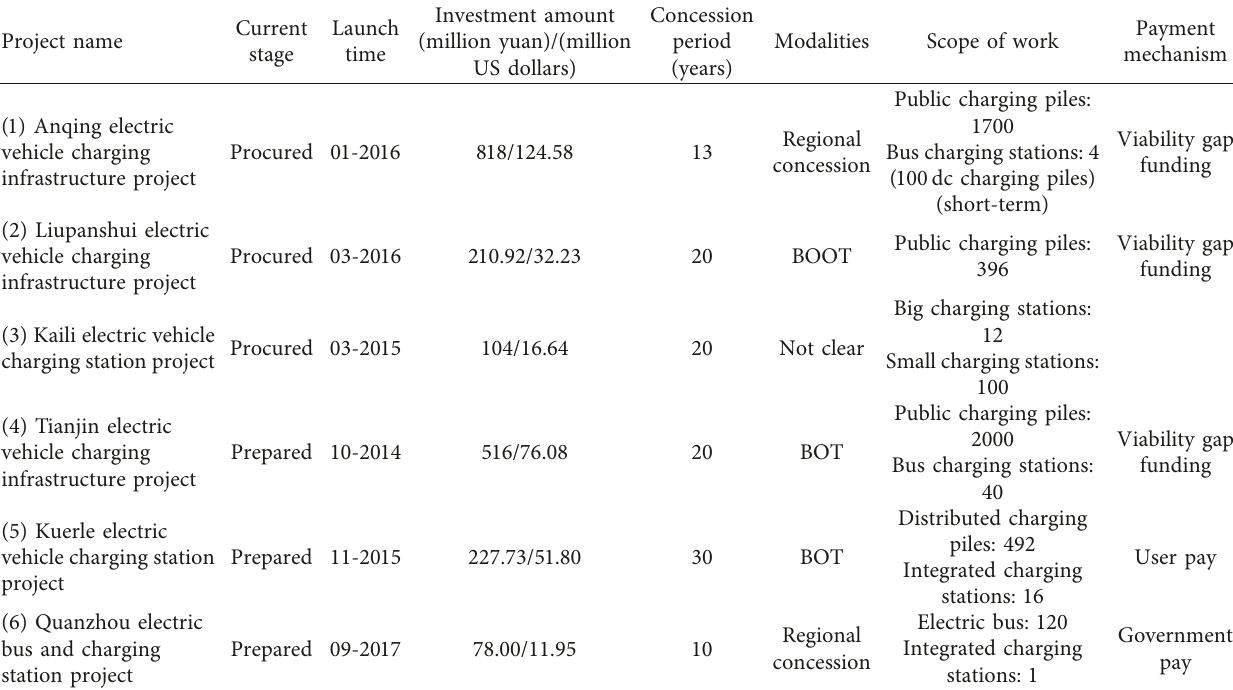
Table 1: Overview of the existing charging infrastructure PPP